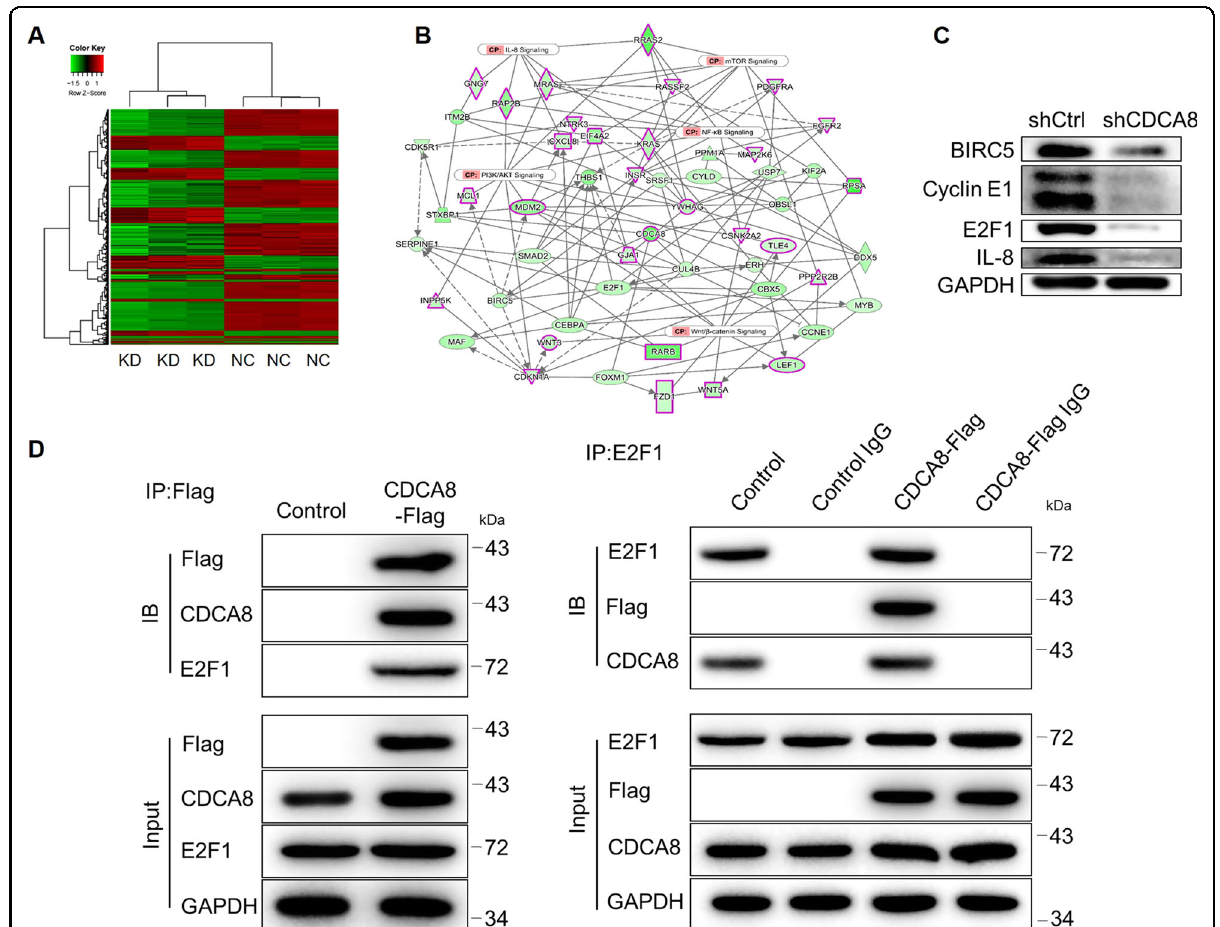
Fig. 4 CDCA8 synergized with E2F1 as the coregulators in glioma. The potential genes pro fi le of the microarray analysis in shCtrl and shCDCA8 U251 cells. A A heatmap was drawn to show the identi fi ed differentially expressed genes between shCtrl and shCDCA8 U251 cells. B The CDCA8- related interaction network was constructed based on the enriched canonical signaling pathway. C The protein levels of some selected differentially expressed genes (BIRC5, Cyclin E1, E2F1, and IL-8) were evaluated by western blotting. D The co-IP assay was carried out in SHG-44 cells for verifying the interaction between CDCA8 and